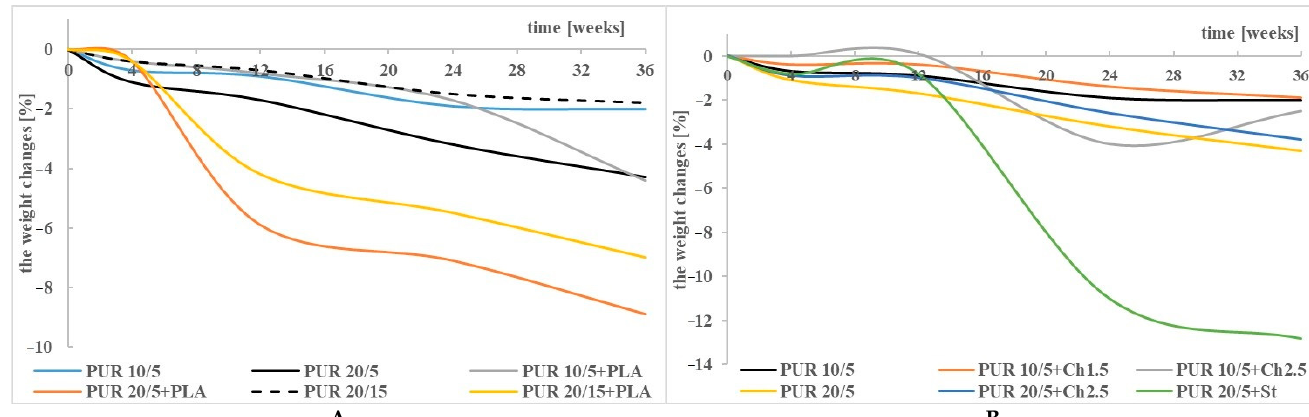
Figure 2. The weight changes of PURs and their blends with PLA ( A ), and Ch and St ( B ) after incubation in a buffer solution. For comparison, PUR 10/5, PUR 20/5 and PUR 20/15 are also shown.